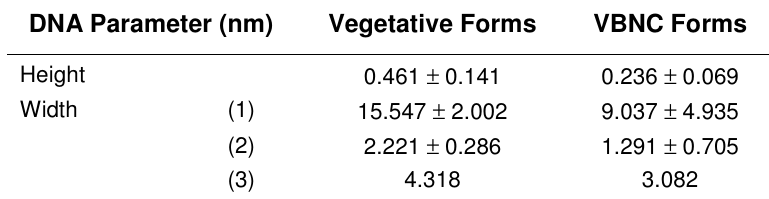
Measured Height and Width of the DNA Molecules at Low Humidity (about 30%) DNA Parameter